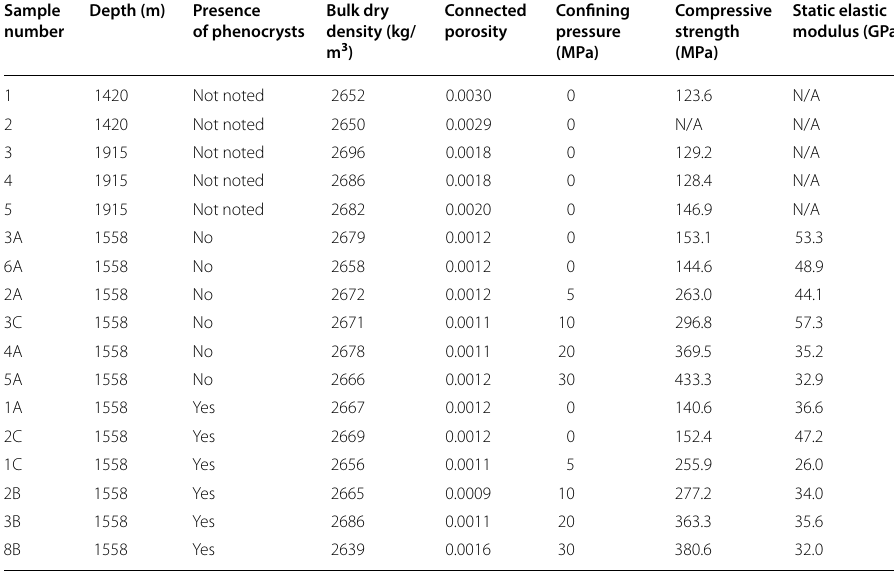
Experiments were performed at a constant strain rate of 10 − 5 s − 1 . As noted in the text, the static elastic modulus could not be determined for the samples recovered from depths of 1420 and 1915 m due to technical problems